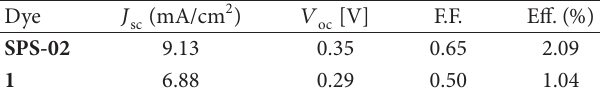
F 4: Photocurrent density-voltage characteristics of device SPS-02 and device 1 under air mass 1.5 (100mWcm T 1: Photovoltaic performance of complex SPS-02 and 1